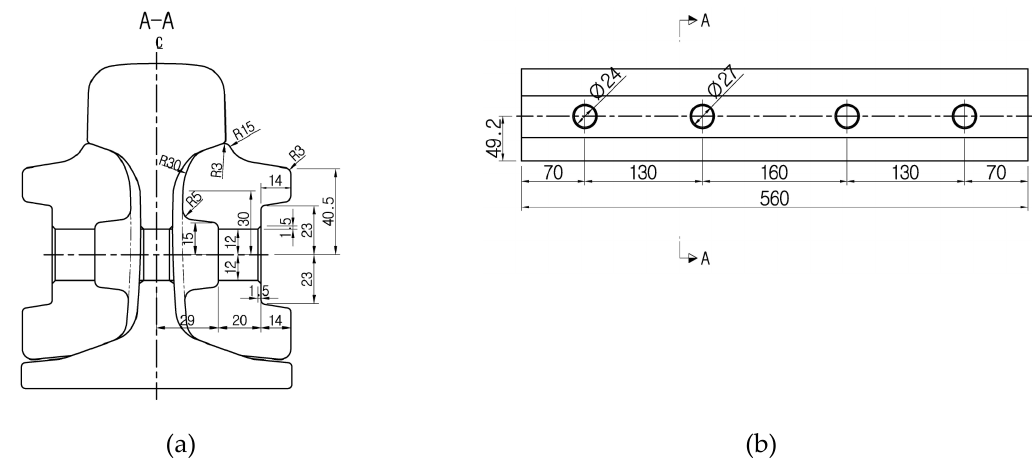
Figure 2. Schematics of the rail joint. ( a ) Cross section of the rail joint; ( b ) side view of the fishplate of the rail joint (unit: mm).